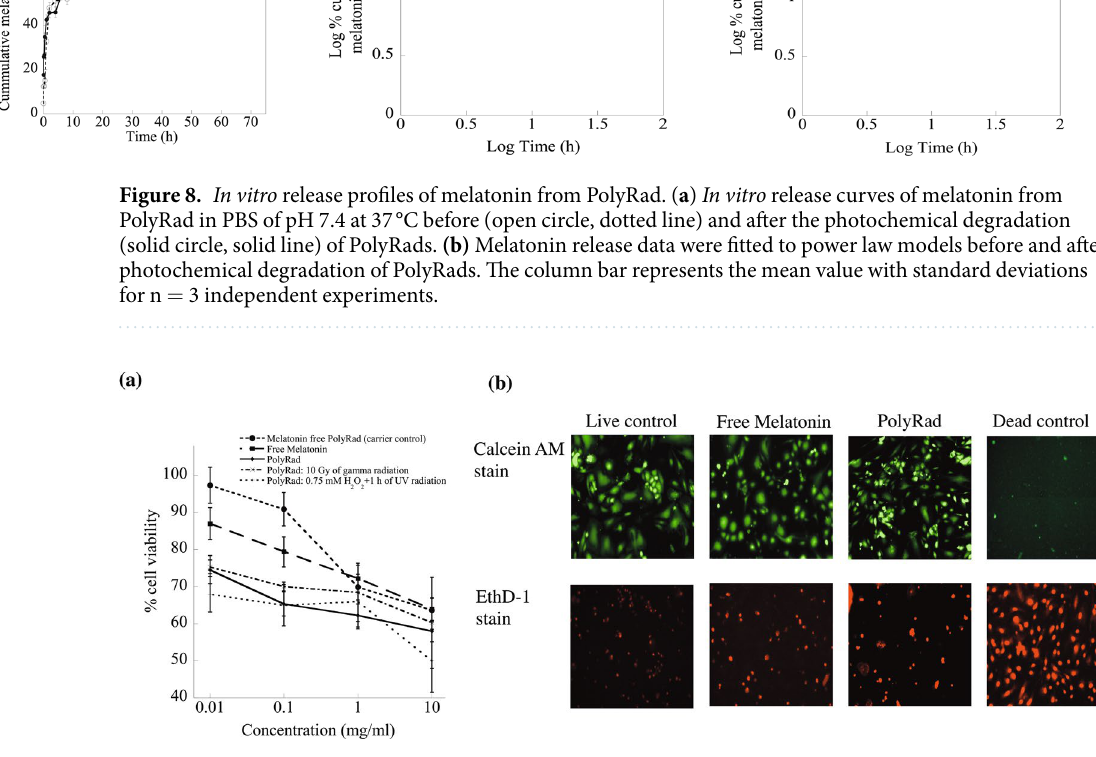
Figure 9. Effect of melatonin on HUVEC cell viability. ( a ) MTT assay shows that PolyRad is non-toxic at concentrations of ≤ 0.01 mg/ml. Data represents mean and standard deviation of three